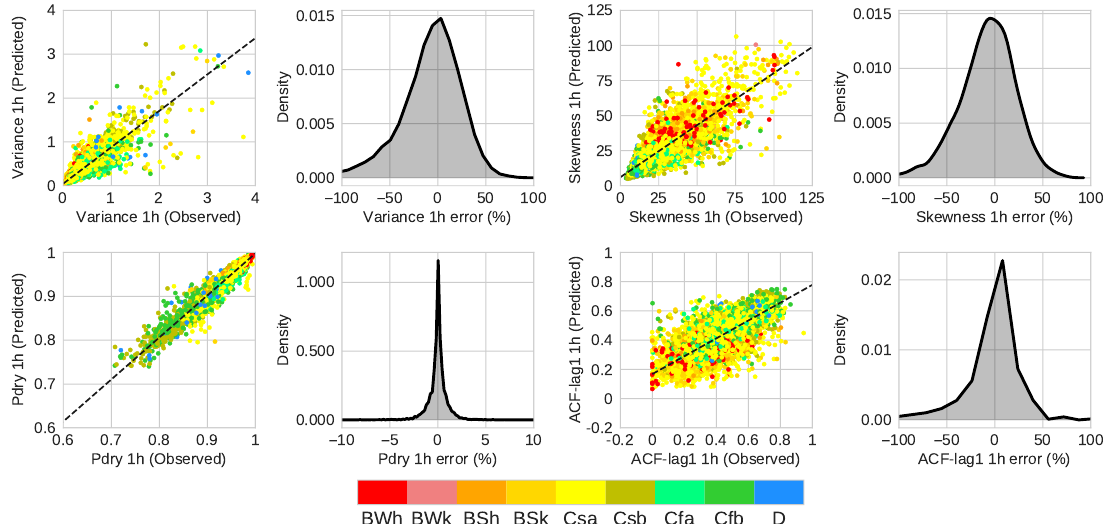
Figure 3. Performance evaluation of the random forests-based model (RFB) for variance, proportion of dry intervals (Pdry), skewness coefficient, and autocorrelation lag-one (ACF-lag1) for 1-h intervals. The first and third columns show the scatter plots of the observed versus downscaled (predicted) values; colors indicate climate type; dashed black line correspond to the linear regression. The second and fourth columns show the relative error (%) distributions through a kernel density estimator representation ( err = ( Obs 2 − Pred 2 ) / Obs 2